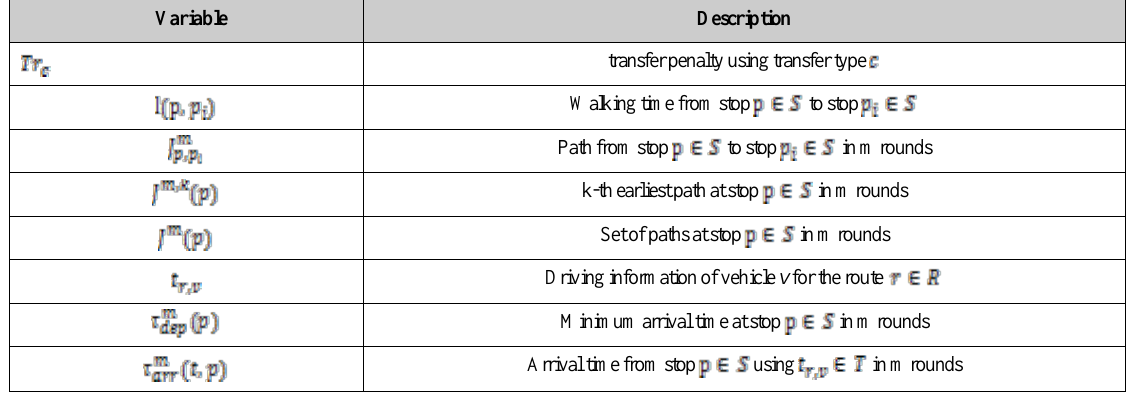
Table 1. Description of major variables in RAPTOR